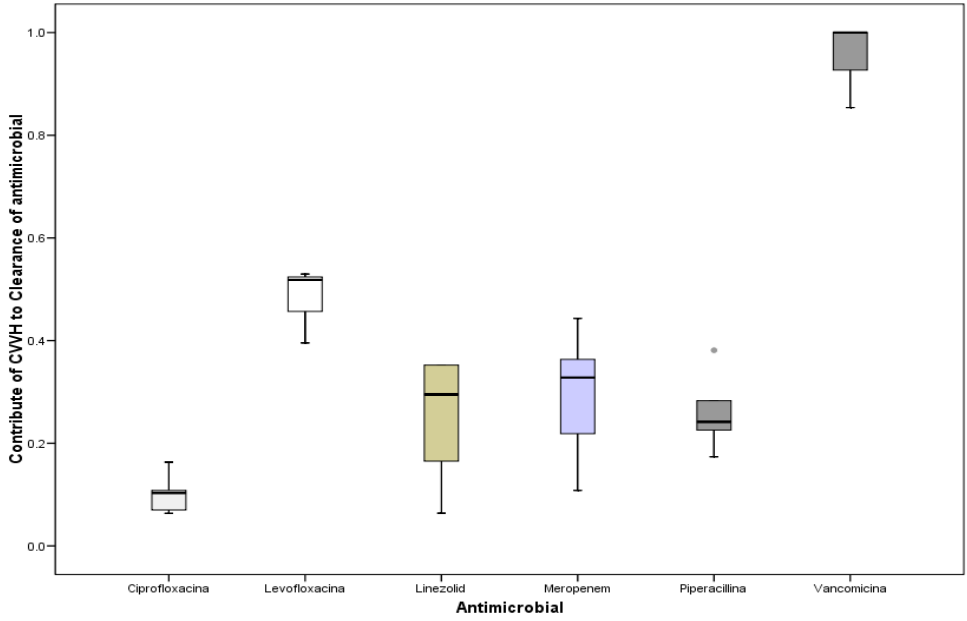
Figure 3. Lines and regression coefficient of the concentration of antibiotics in plasma in UF at the trough levels and peak concentration. * Multiplication sign.